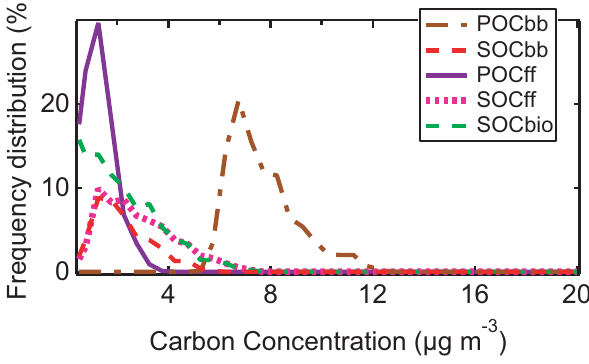
Fig. 1. Example of QMC solution frequency distributions corre- sponding to primary and secondary OC concentrations; EC fre- quency distributions are not reported for